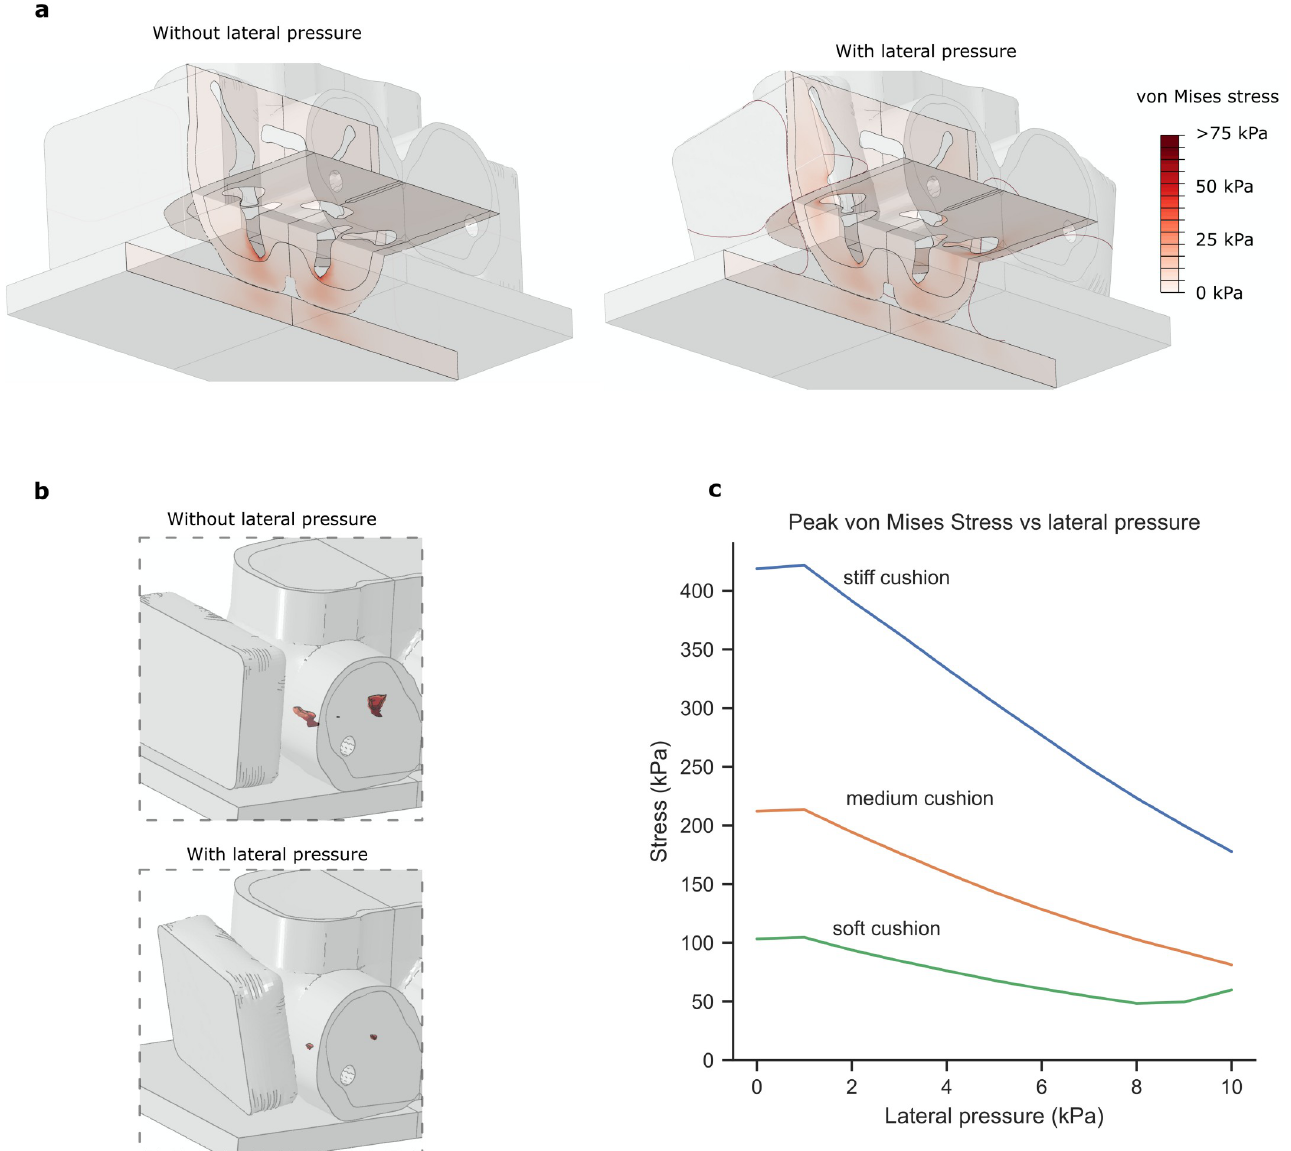
Fig 5. A 3D model of the seated pelvis under load. (a) Results for the stiff cushion shown with and without lateral pressure applied. Coronal and transverse sections are shown to indicate von Mises stresses both at the ischial tuberosities and the greater trochanter. (b) The volume of soft tissue exposed to high stresses ( > 32kPa) is shown in relation to the whole pelvis. The whole pelvis is made transparent to help visualise the location of high stresses (beneath the ischial tuberosity) (c) Change in peak von Mises stress throughout the soft tissue of the pelvis (surrounding both the ischium and the femur) as lateral pressure is